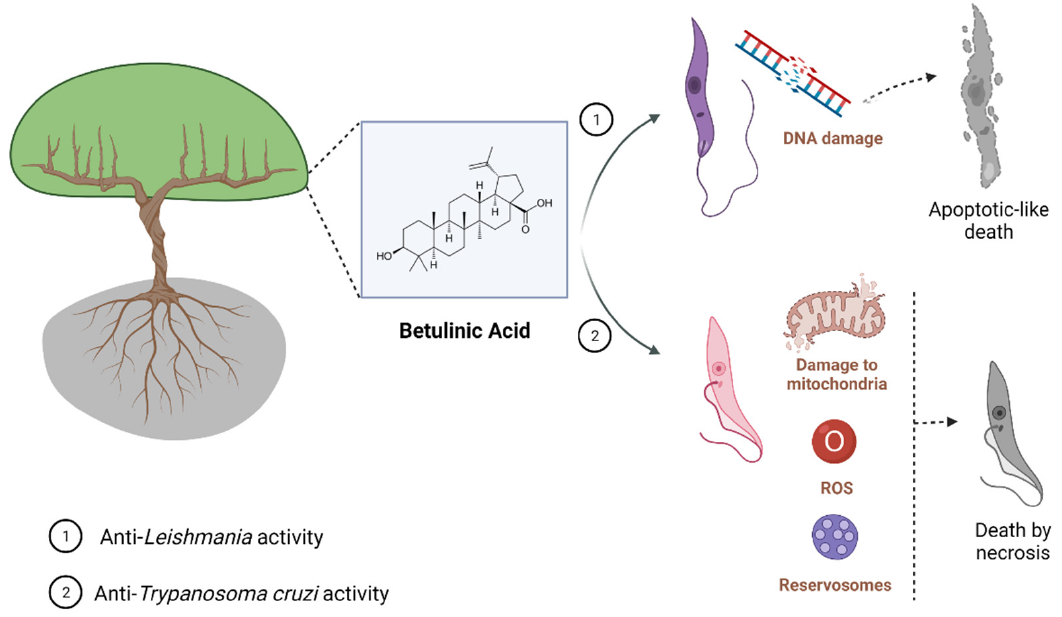
Figure 1. Known mechanisms of parasite activity against Leishmania and T. cruzi . Previous work showed that dihydrobetulinic acid inhibits the interaction between topoisomerases I and II with the parasite DNA, inducing DNA brake and an apoptotic-like death in promastigotes and amastigotes. Regarding T. cruzi , it was shown a direct effect of BA5 on plasma membrane integrity, the formation of numerous and atypical vacuoles within the cytoplasm of the parasite, dilatation of some Golgi cisternae, and appearance of profiles of endoplasmatic reticulum involving organelles accompanied by the formation of autophagosomes, which ultimately result in trypomastigote cell death by necrosis. BA5 also reduced M1 markers and upregulated the M2 markers, inducing a regulatory